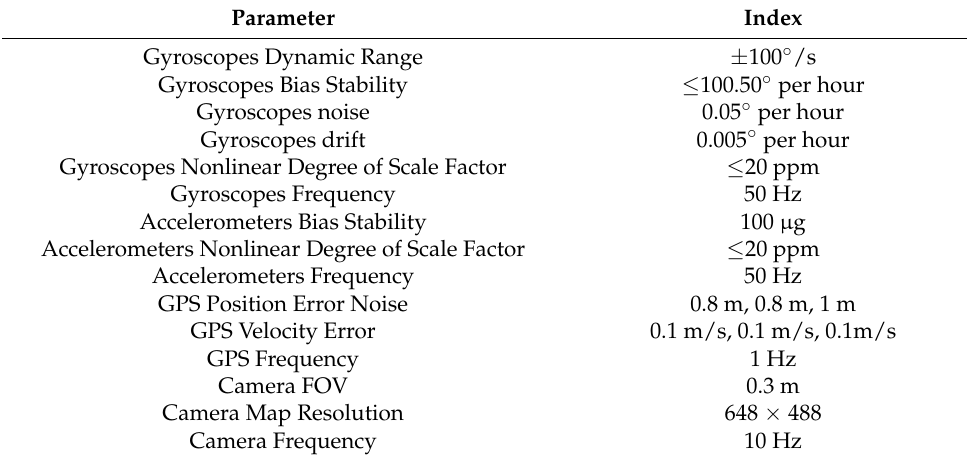
Table 1. Specifications of the navigation